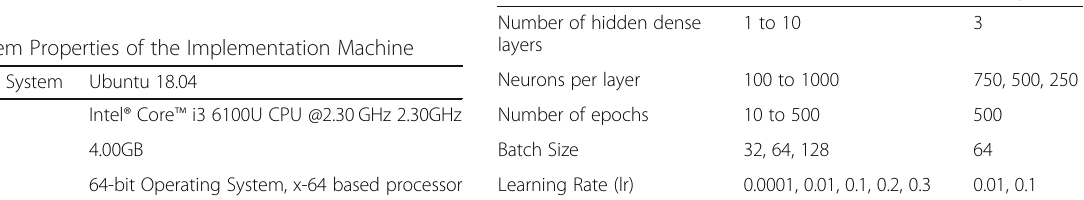
Table 4 Hyperparameters for Optimal Model Performance